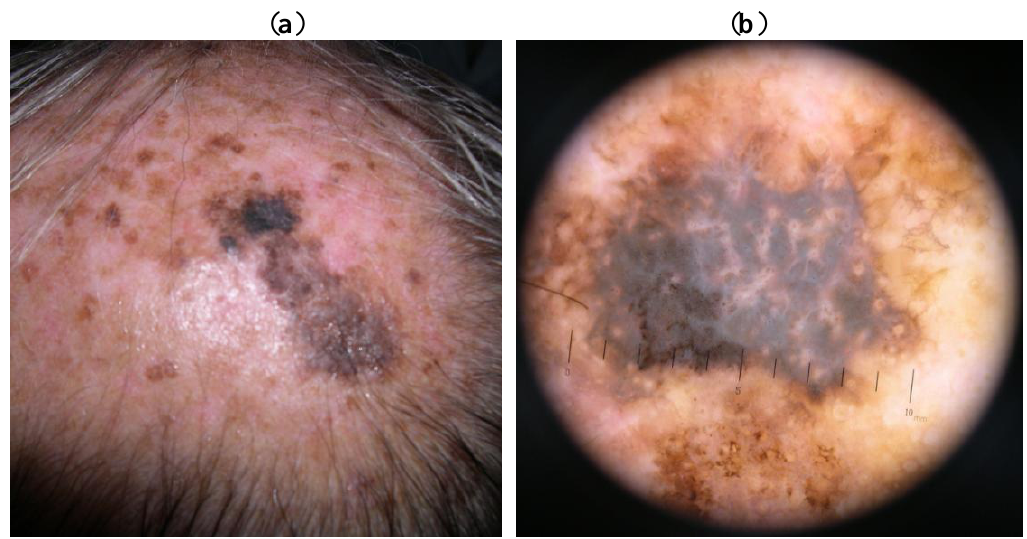
Figure 2. Case 2. ( a ). Naked eye aspect: a 10 mm, irregular black patch among several sebhorreic keratosis; ( b ). Dermatoscopic aspect: a blackish rhomboidal structure, irregular streaks and a central white-blue